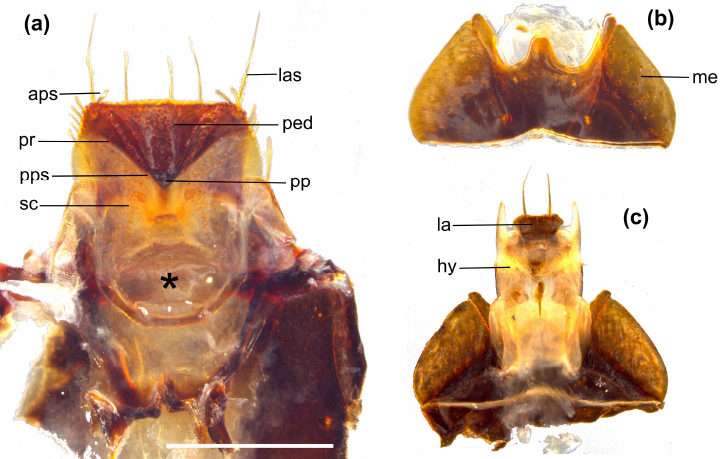
Figure 8. Mouthparts of P. complanatus : ( a ) epipharynx (ep): aps = anterior parapedial setae; las = labral apical seta; ped = pedium; pp = parapedial projection; pr = parapedial ridge; pps = posterior parapedial setae; sc = sensillum coeloconicum. The cibarial opening (identified by the asterisk) is markedly surrounded by a sclerotized arc. Scalebar = 0.5 mm. ( b ) mentum (me) and ventral view. ( c ) labium (la) and hypopharynx (hy). The labial palps were cut